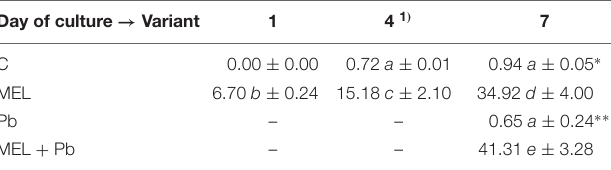
TABLE 1 | Melatonin concentration (ngMEL/gFW) in homogenates of BY-2 cells in crucial points of conducted experiments. Day of culture → Variant 1 4 1